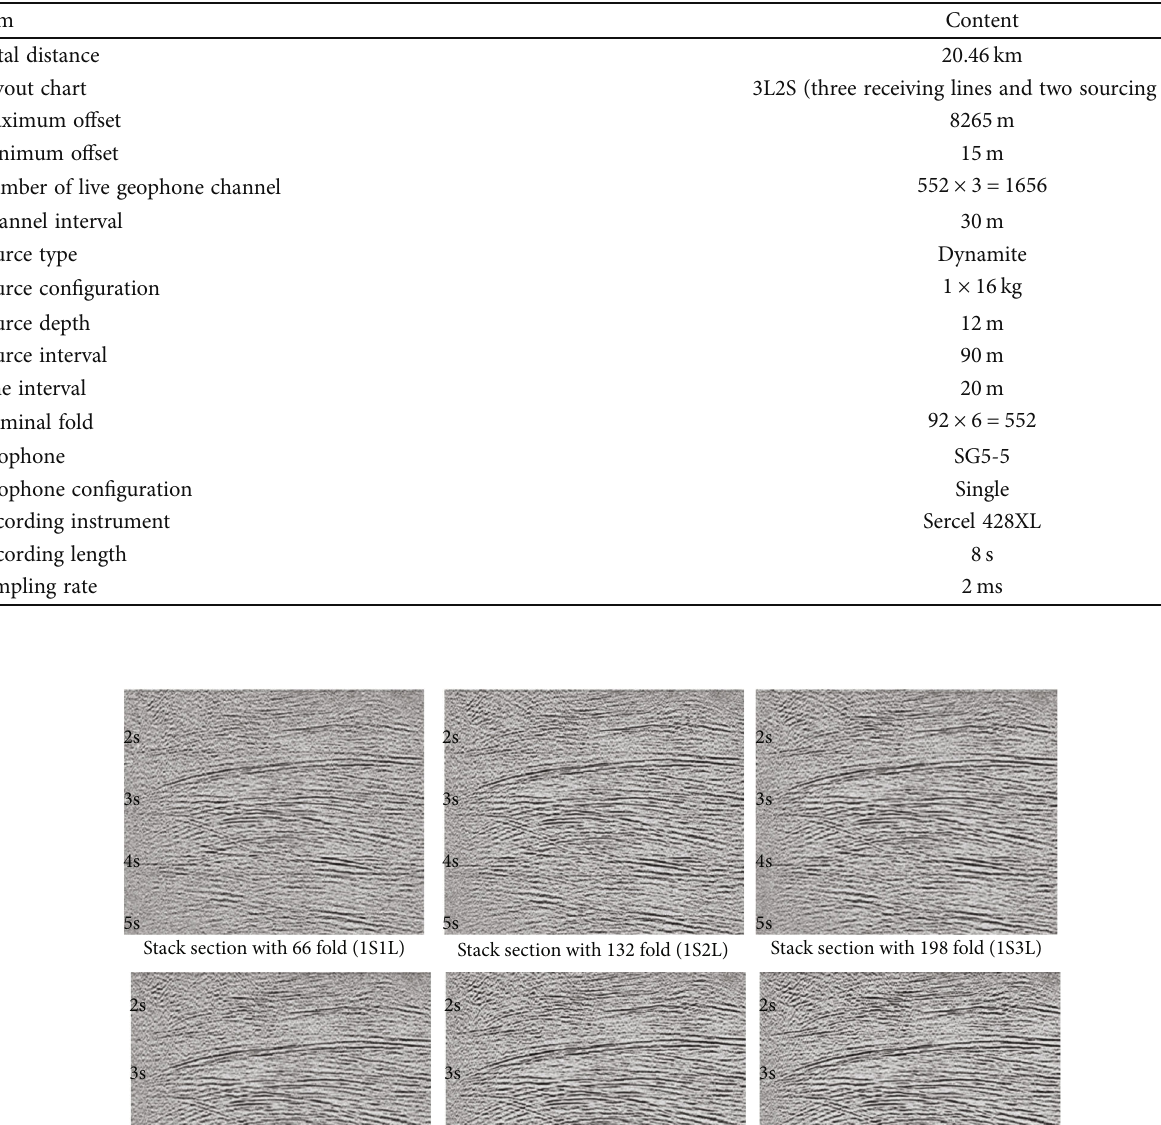
Table 3: Acquisition parameters for wide-line pro fi ling test.